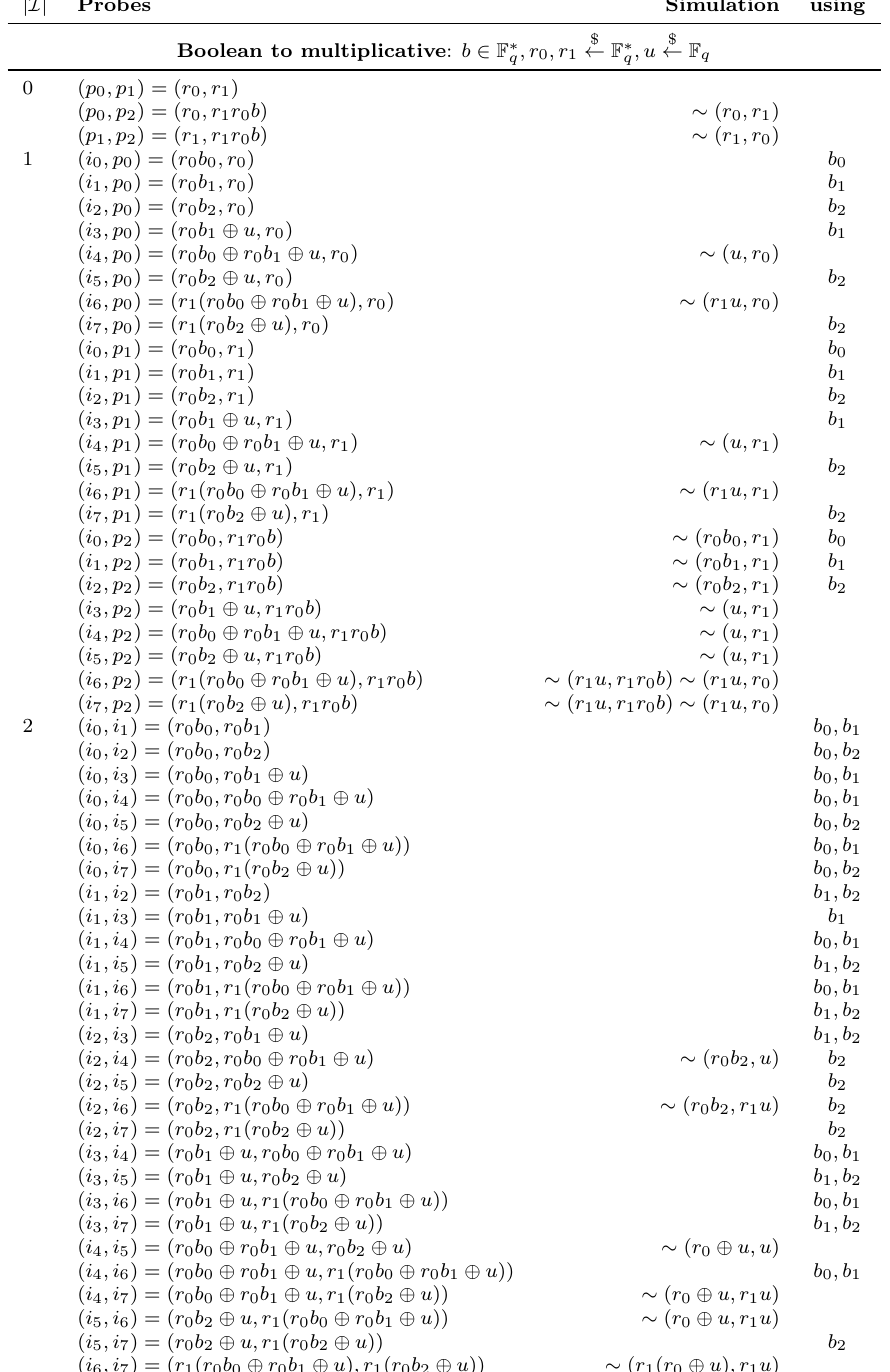
Table 8: Simulation of intermediate probes I and output probes O such that |I| + |O| ≤ d = 2 using |I| input shares for the second-order Boolean to multiplicative